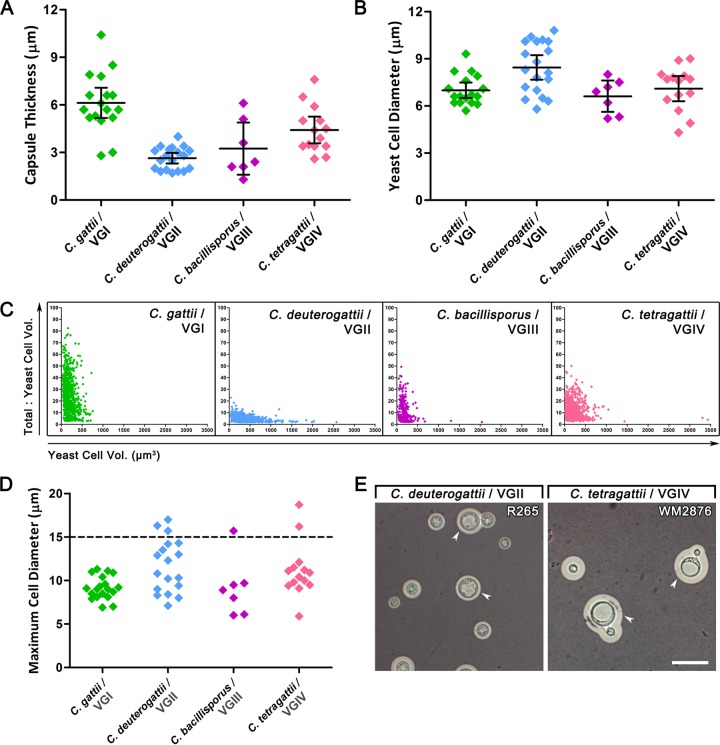
Cell diameter and capsule thickness across species in the C. gattii complex after growth on CIM-20. (A and B) Capsule thickness (A) and yeast cell diameter (B) of isolates from each species grown on CIM-20 with 5% CO2 at 37°C for 5 days. Each symbol represents the average value for 50 cells measured for a single isolate. Values are means (horizontal bars) ± 95% confidence intervals (error bars) for C. gattii/VGI (n = 17), C. deuterogattii/VGII (n = 19), C. bacillisporus/VGIII (n = 7), and C. tetragattii/VGIV (n = 14) strains. (C) Average yeast cell volume plotted against the average total cell/yeast cell volume ratio of 3,000 individual cells across all four species. Cells sitting further up the y axis possess larger relative capsular volume, while cells sitting further along the x axis possess larger cell volumes. (D) Maximum cell diameter measured across 50 cells for each isolate. C. deuterogattii/VGII, C. bacillisporus/VGIII, and C. tetragattii/VGIV isolates infrequently exhibited giant cells greater than 15 µm in diameter. (E) Indian ink preparations of representative strains from C. deuterogattii/VGII and C. tetragattii/VGIV showing giant cells indicated by white arrowheads. Bar = 30 µm.